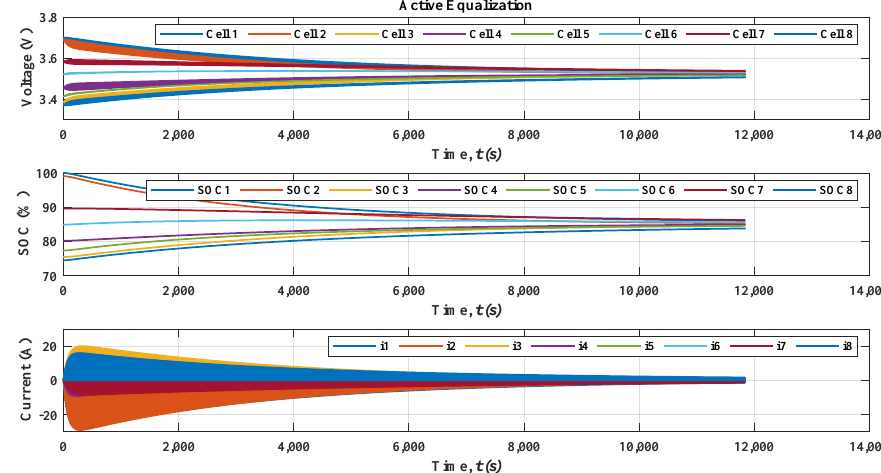
Figure 5. Passive cell-level equalization.